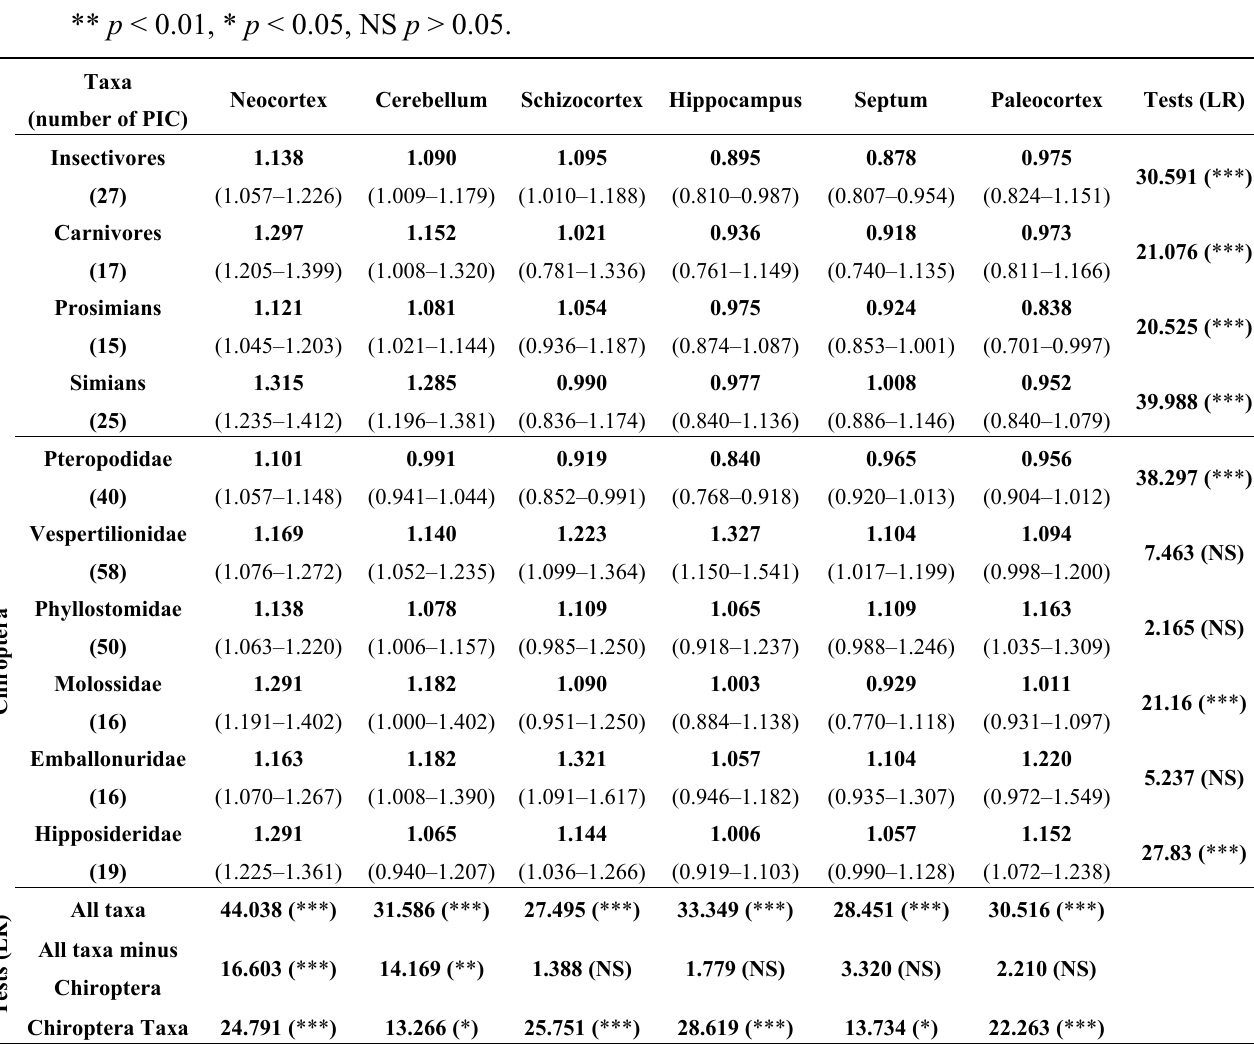
Table 1. Estimate of the slope (Major Axis Regression forced at the origin, see Methods) of phylogenetically independent contrasts (PIC) of the logged brain structure sizes regressed onto the independent contrast of the logged brain core. See Methods for a description of the test for common slope. Symbols for significance level are: *** p <